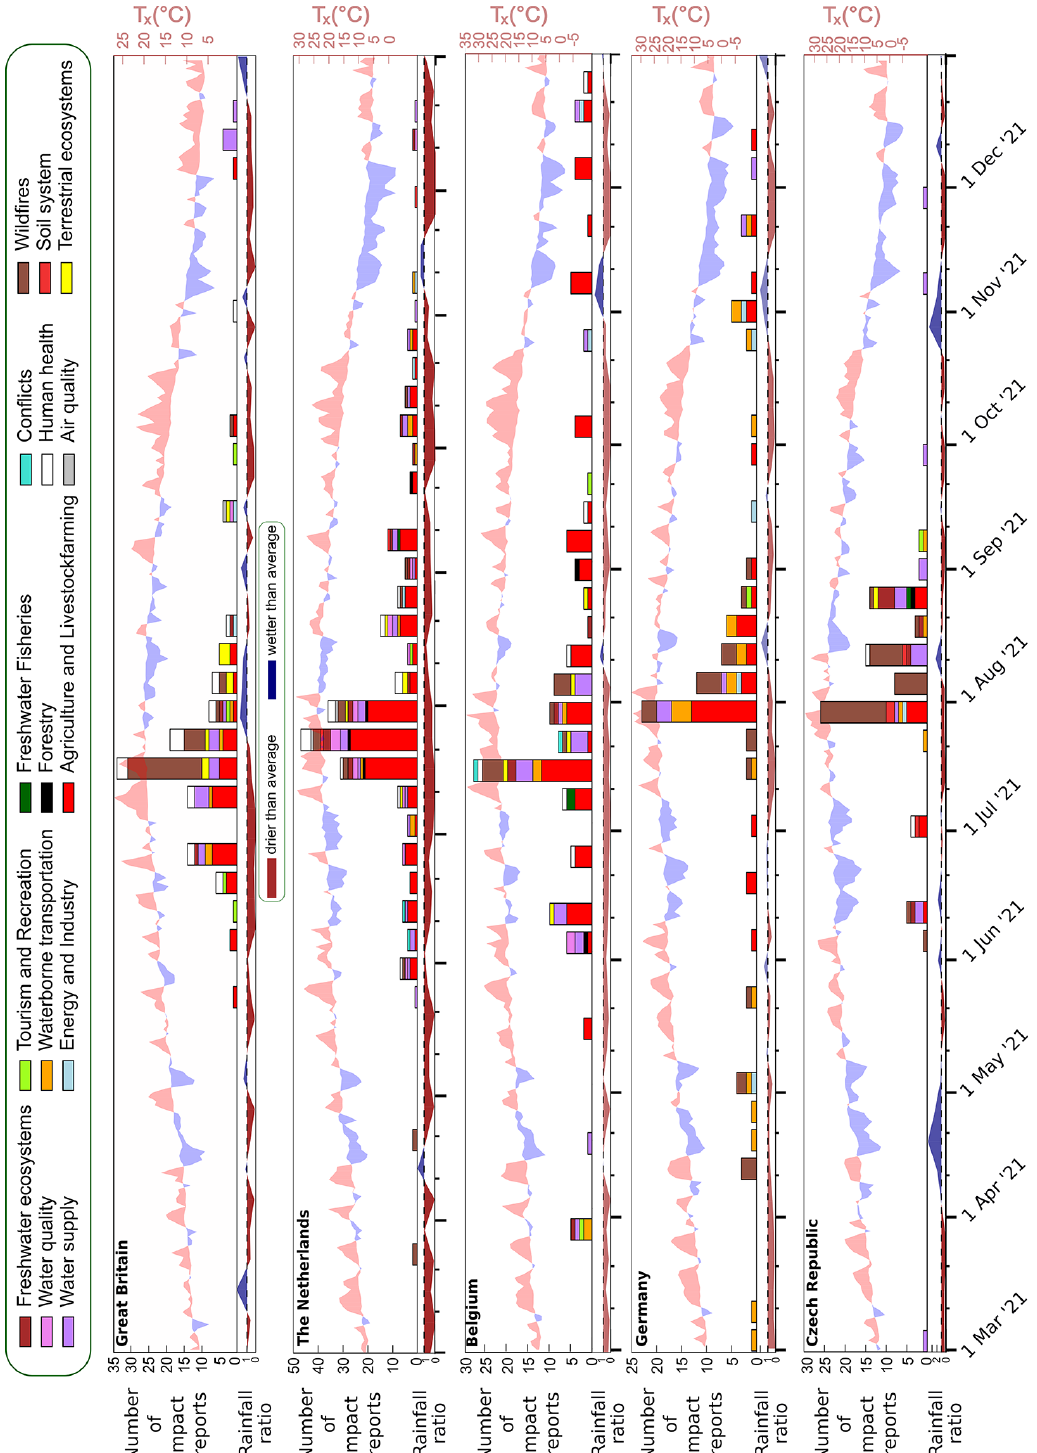
Figure 1. Graphs showing reported impact type for the United Kingdom, the Netherlands, Belgium, Germany and the Czech Republic (top to bottom). The vertical axis shows the number of reports, the horizontal axis shows the date associated with the publication of the text-based report. Below each impact graph, the weekly sum of rainfall, averaged over the country and as the ratio with the corresponding climatological period, is shown where brown relates to lower-than-expected values. In the background, daily maximum temperatures, averaged over the country, are shown as deviations from the climatology. Temperature and precipitation data are based on the E-OBS dataset introduced in this